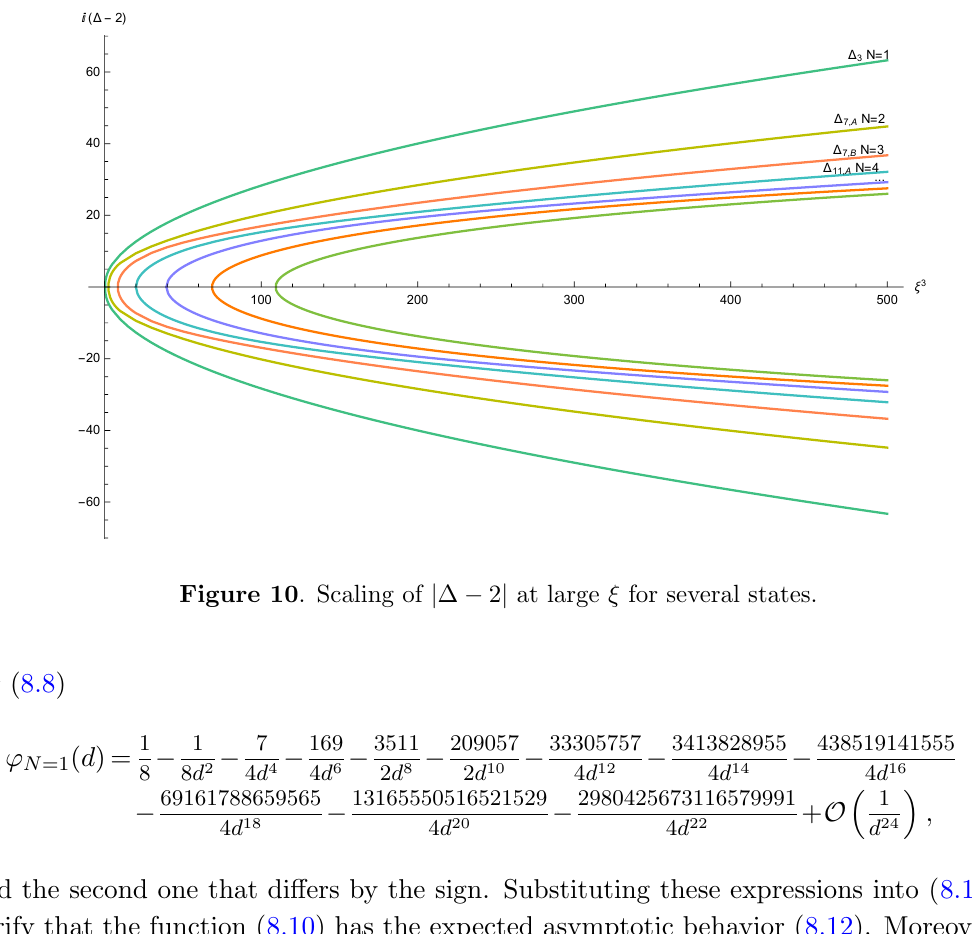
Figure 10 . Scaling of j (cid:1) (cid:0) 2 j at large (cid:24) for several